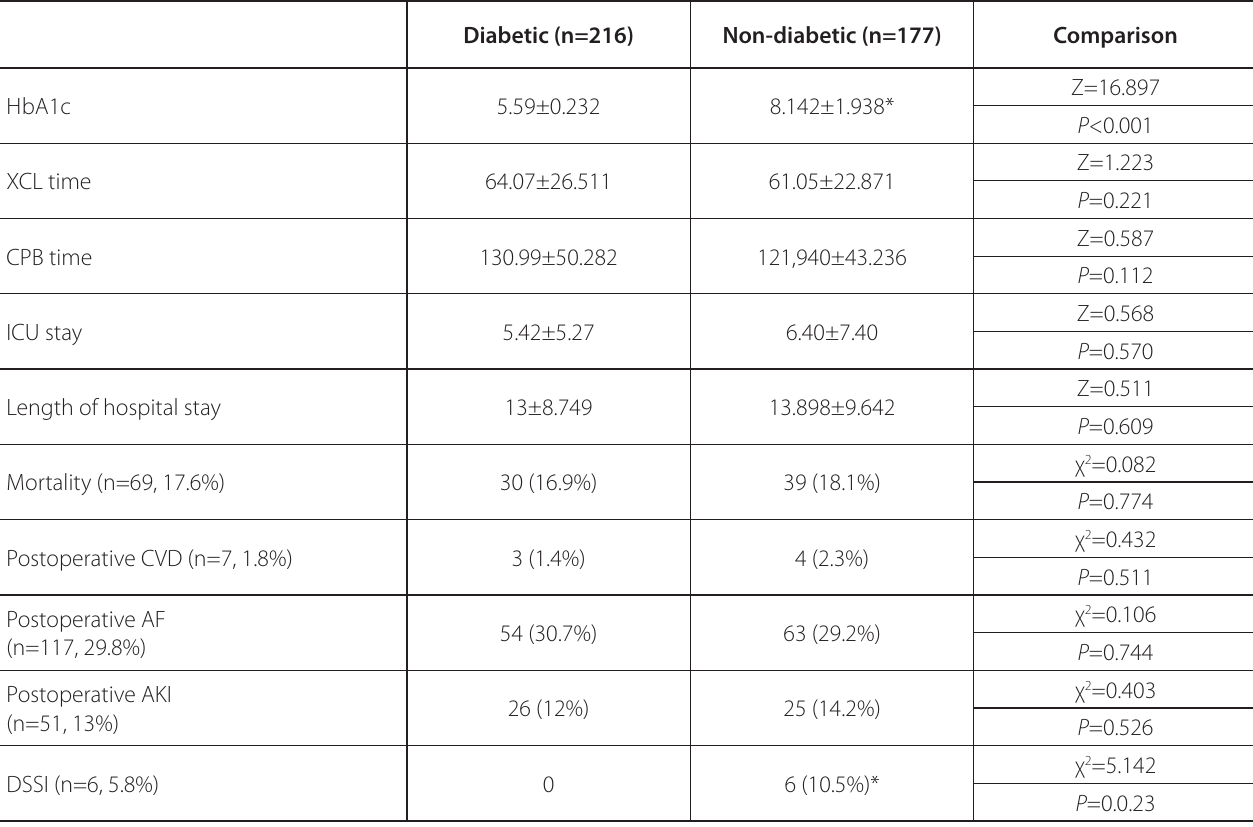
Table 1 . Distribution of patients according to diabetic